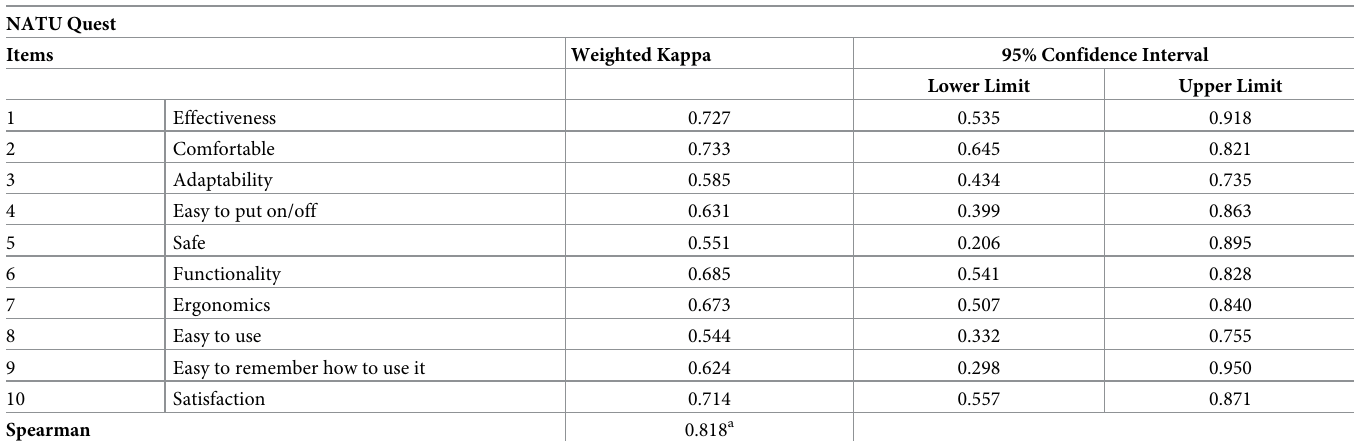
Table 7. NATU quest reliability of the